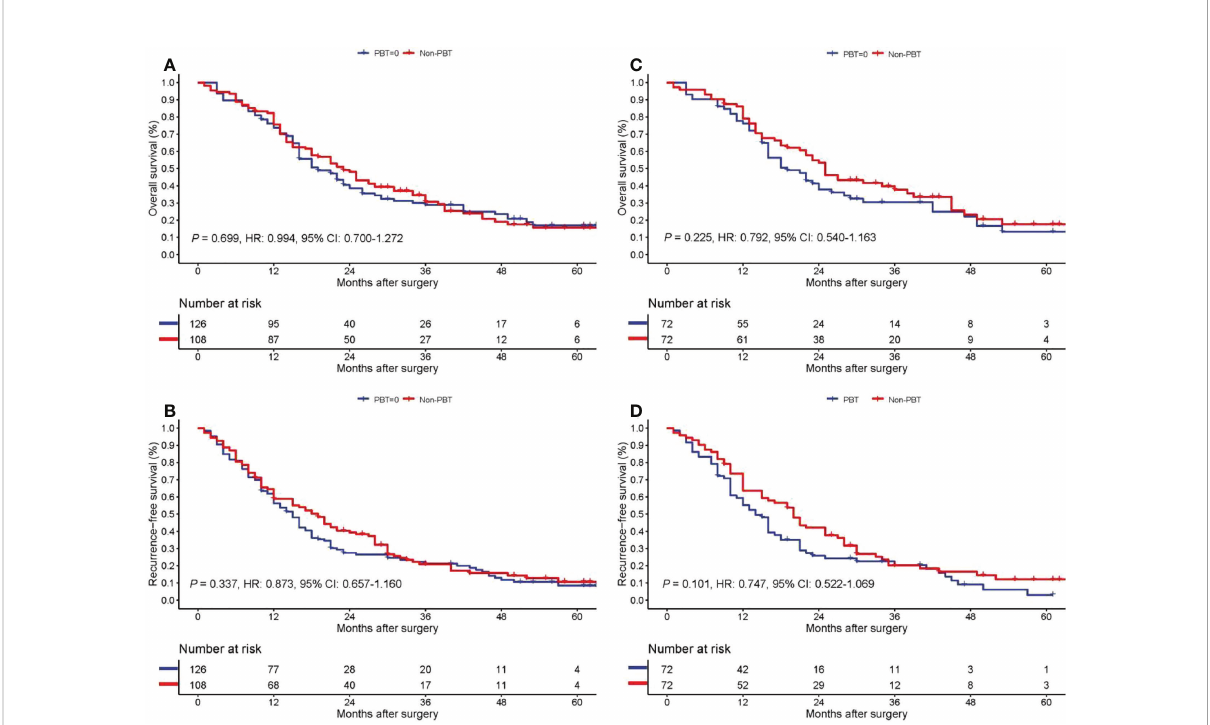
FIGURE 3 Kaplan − Meier curves of overall survival (A) and recurrence-free survival (B) for the PBT and non-PBT groups among patients with non-early stage (8th AJCC stage II-IV) pCCA treated with curative resection before PSM. Kaplan − Meier curves of overall survival (C) and recurrence-free survival (D) for the PBT and non-PBT groups among patients with non-early stage (8th AJCC stage II-IV) pCCA treated with curative resection after PSM. CI, con fi dence interval; HR, hazard ratio; PBT, perioperative blood transfusion; PSM, propensity score